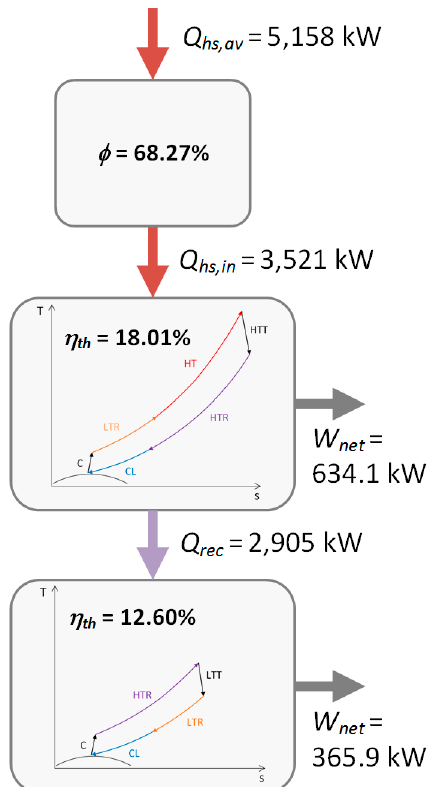
Figure 15. Dual recuperated cycle. Breakdown of the overall performance into a chain of efficiencies, which include the thermal efficiencies of the elementary cycles.